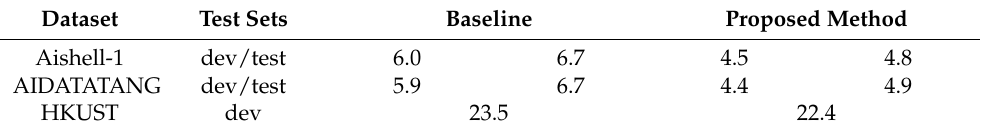
Table 2. Comparison of experiments on different datasets.